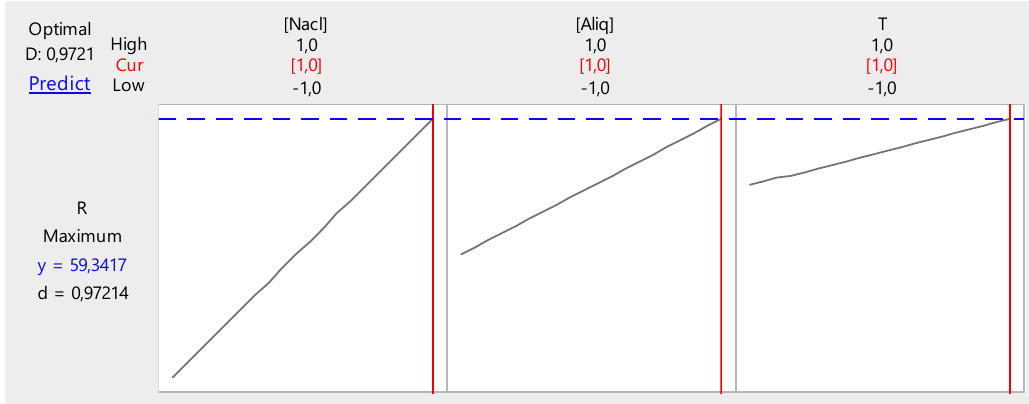
Figure 16. Factor optimization for Cr(VI) extraction.